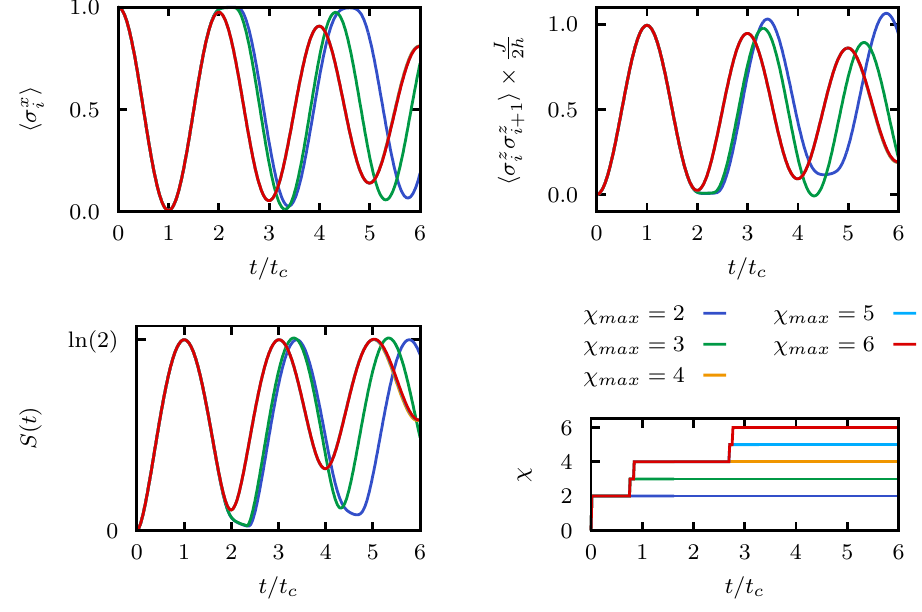
= ∞ to h / J = 0.05 computed with iTEBD with 0 max